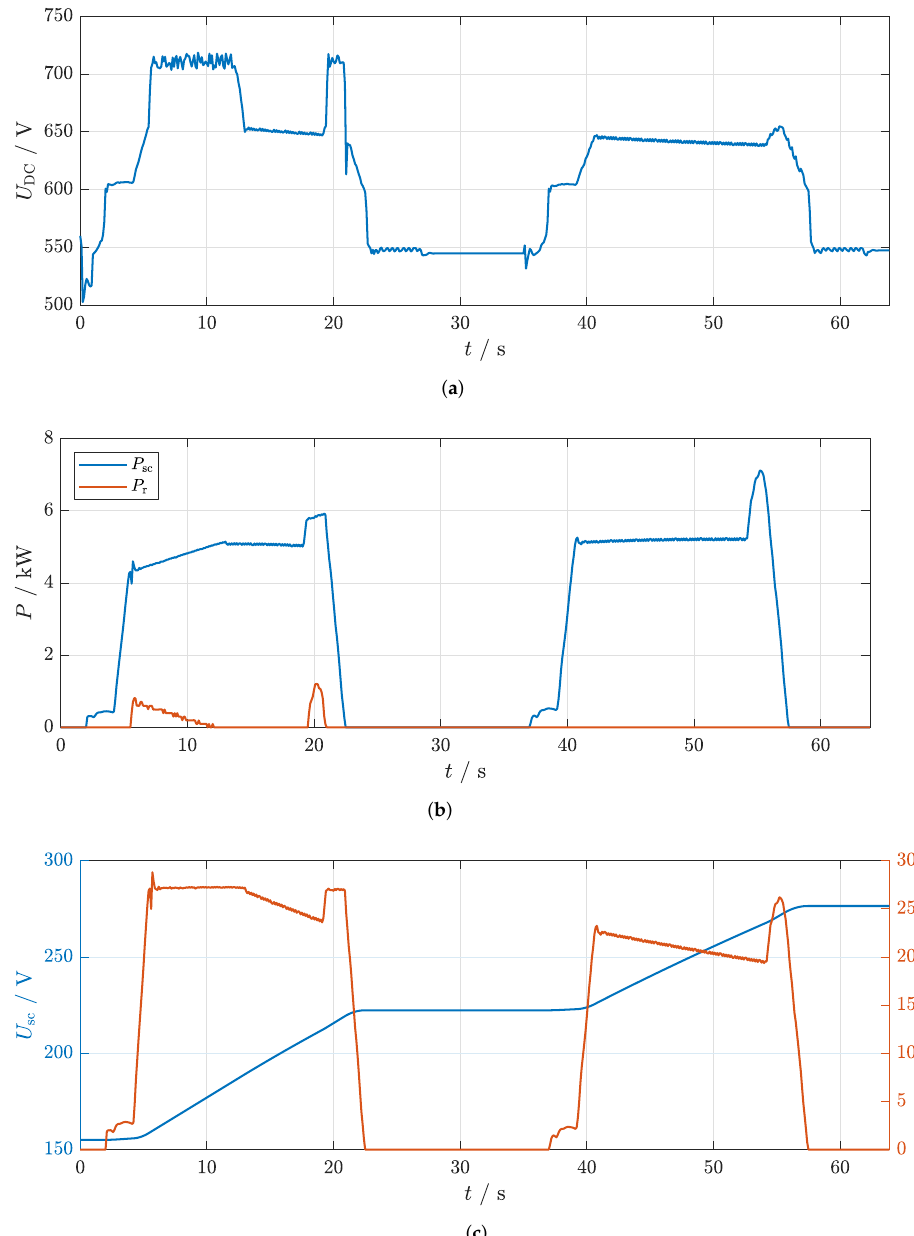
Figure 14. Simulation results for two consecutive regenerative trips. ( a ) DC bus voltage. ( b ) SC bank power and braking resistor power. ( c ) Voltage and current of the SC